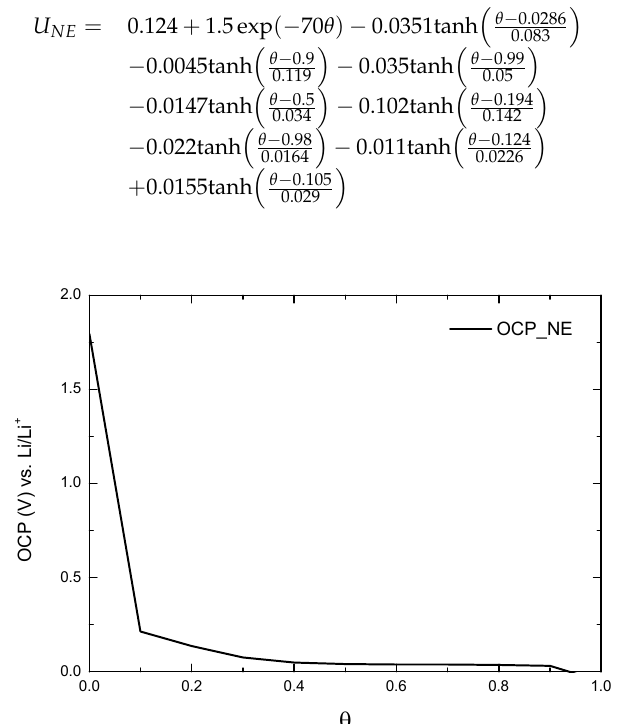
Figure A1. OCP curve for the graphite electrode as a function of the dimensionless lithium content, θ .